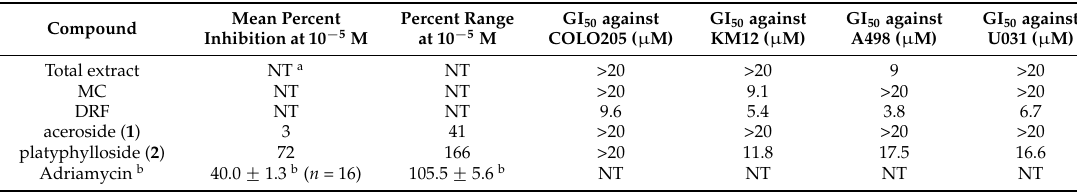
Table 2. Cytotoxicity of compounds in the NCI 60-cell